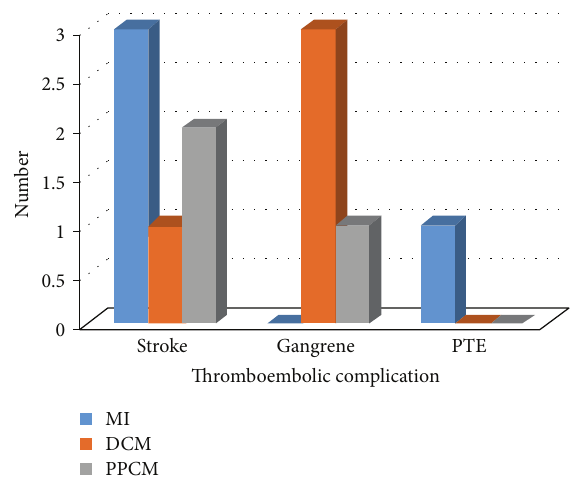
Figure 2: Presenting thromboembolic complications among patients with left ventricular thrombus. DCM = dilated cardi- omyopathy; MI = myocardial infarction; PPCM = peripartum cardiomyopathy; PTE = pulmonary thromboembolism.